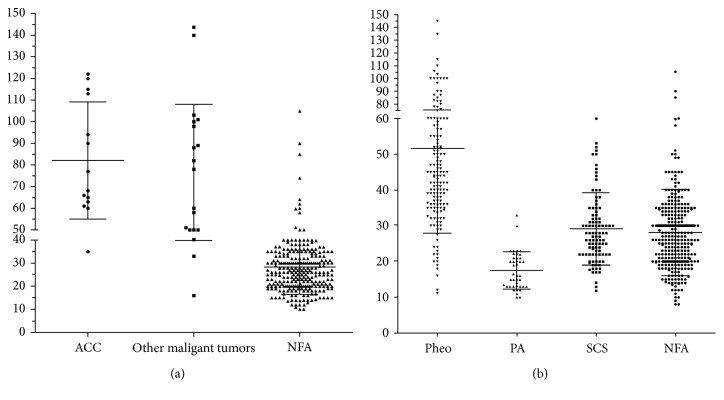
(a) The individual sizes of different functional tumors. (b) The individual sizes of benign and malignant tumors. Other malignant tumors include metastatic carcinoma, lymphoma, and sarcoma. SCS: subclinical Cushing syndrome; PA: primary hyperaldosteronism; Pheo: pheochromocytoma; ACC: adrenal cortical; carcinoma.